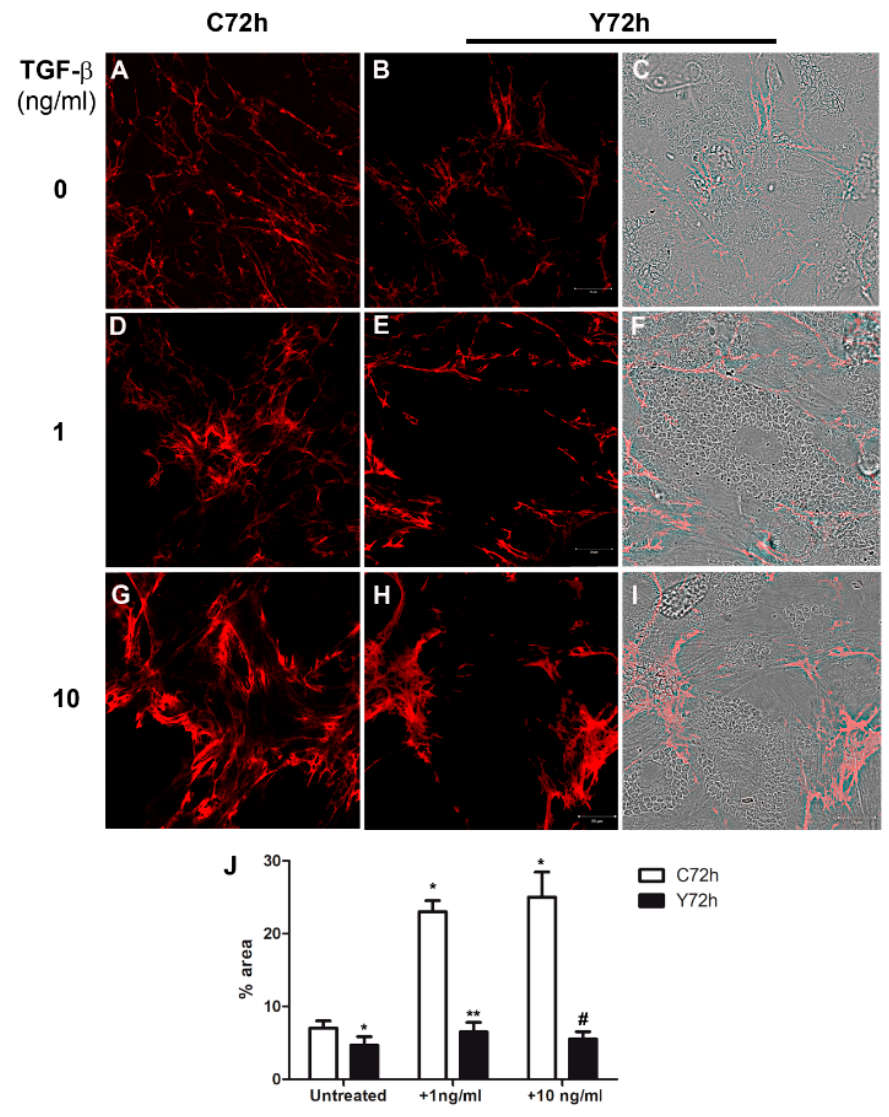
Figure 4. Distribution of fibronectin in L6E9 skeletal myoblasts infected with T. cruzi and treated with TGF- β . T. cruzi infection (72 h) reduced FN fibrils staining (red) in L6E9 skeletal myoblasts ( B , C ) when compared to uninfected controls ( A ). The treatment of T. cruzi infected L6E9 skeletal myoblasts with 1 ng/mL ( E , F ) or 10 ng/mL ( H , I ) of TGF- β induced an increase in FN expression only in uninfected areas in this culture when compared to uninfected TGF- β treated cultures (( D ) 1 ng/mL; ( G ) 10 ng/mL), which presented widespread enhancement of FN. ( J ) Measurement of FN staining area with Image J software showed a reduction of the FN area after infection and a thickening of FN fibrils after TGF- β treatment in uninfected cultures. Differential interference contrast (DIC) was used to show the intracellular parasites in the host cells. * p ≤ 0.05 vs. untreated, uninfected control (C72h); ** p ≤ 0.05 vs. uninfected + 1 ng/mL TGF- β ; # p ≤ 0.05 vs. uninfected + 10 ng/mL TGF- β . Bar = 20 μ m.